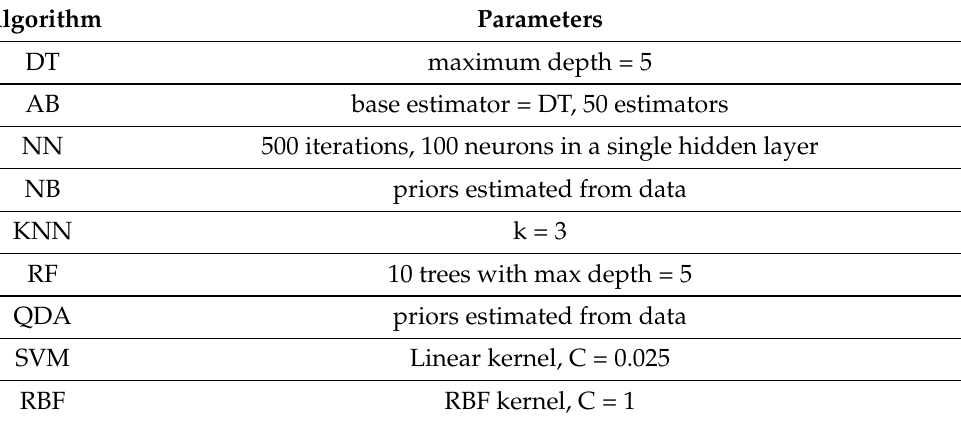
Table 2. Parameter values for algorithm Decision Tree (DT), AdaBoost (AB), Neural Net (NN), Naive Bayes (NB), Nearest Neighbors (KNN), Radial Basis Function (RBF), Random Forest (RF), Quadratic Discriminant Analysis (QDA), and Linear Support Vector Machines